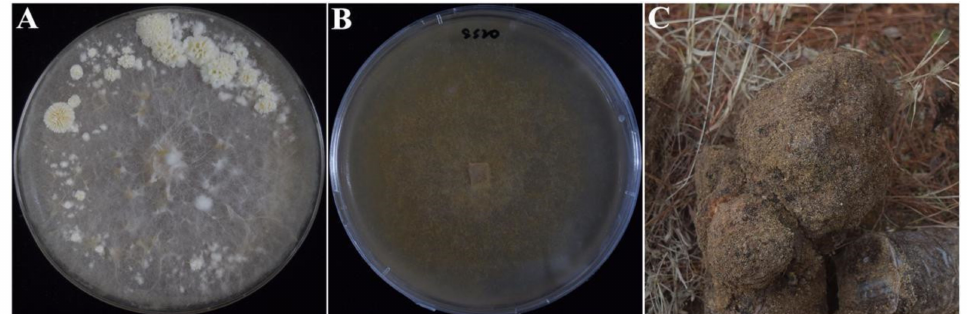
Figure 10. Fruiting bodies, sclerotia, and homokaryotic strain SS20 of W. hoelen strain CGMCC 5.545. ( A ) Fruiting bodies of W. hoelen strain CGMCC 5.545; ( B ) Homokaryotic strain SS20; ( C ) Artificially cultivated sclerotia of W. hoelen strain CGMCC